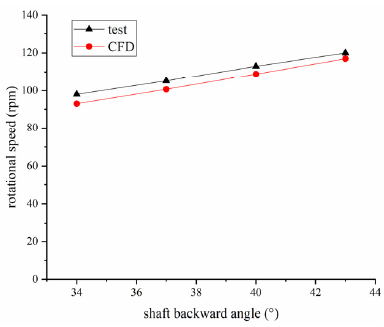
Figure 8. Rotational speed with δ s at θ = 0 ◦ , v = 0.306 m/s.